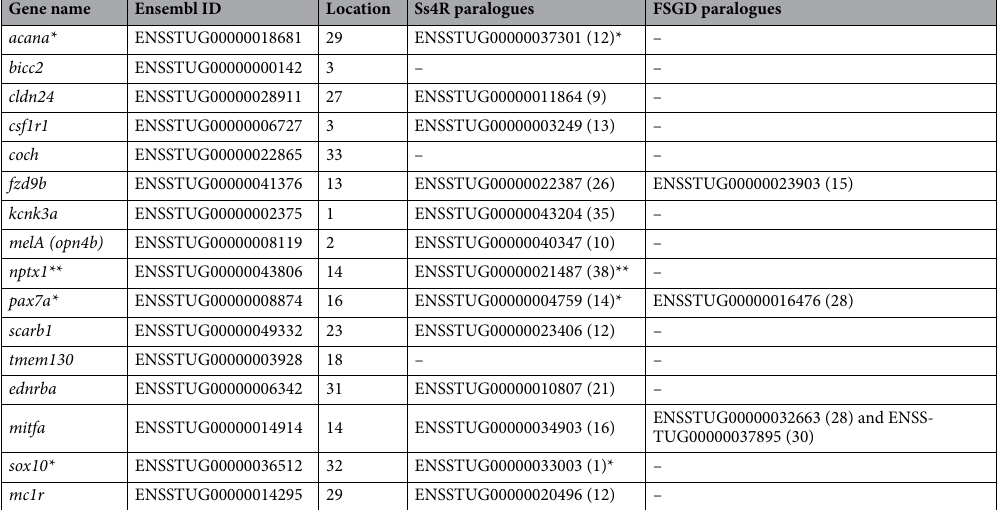
Table 1. Results of the original primer blasts against the brown trout genome. The Ensembl ID of the best hit and primary assembly location (considered as chromosome number) are reported. For paralogues, duplication events (Ss4R/FSGD), Ensembl IDs, and locations (in brackets next to Ensembl ID) are reported. Primers that match both paralogues are marked with ** next to the gene name; * denotes that one of the primers has one or two nucleotide mismatches to other paralogues. In both cases, both paralogues could be potentially amplified in the first qPCR